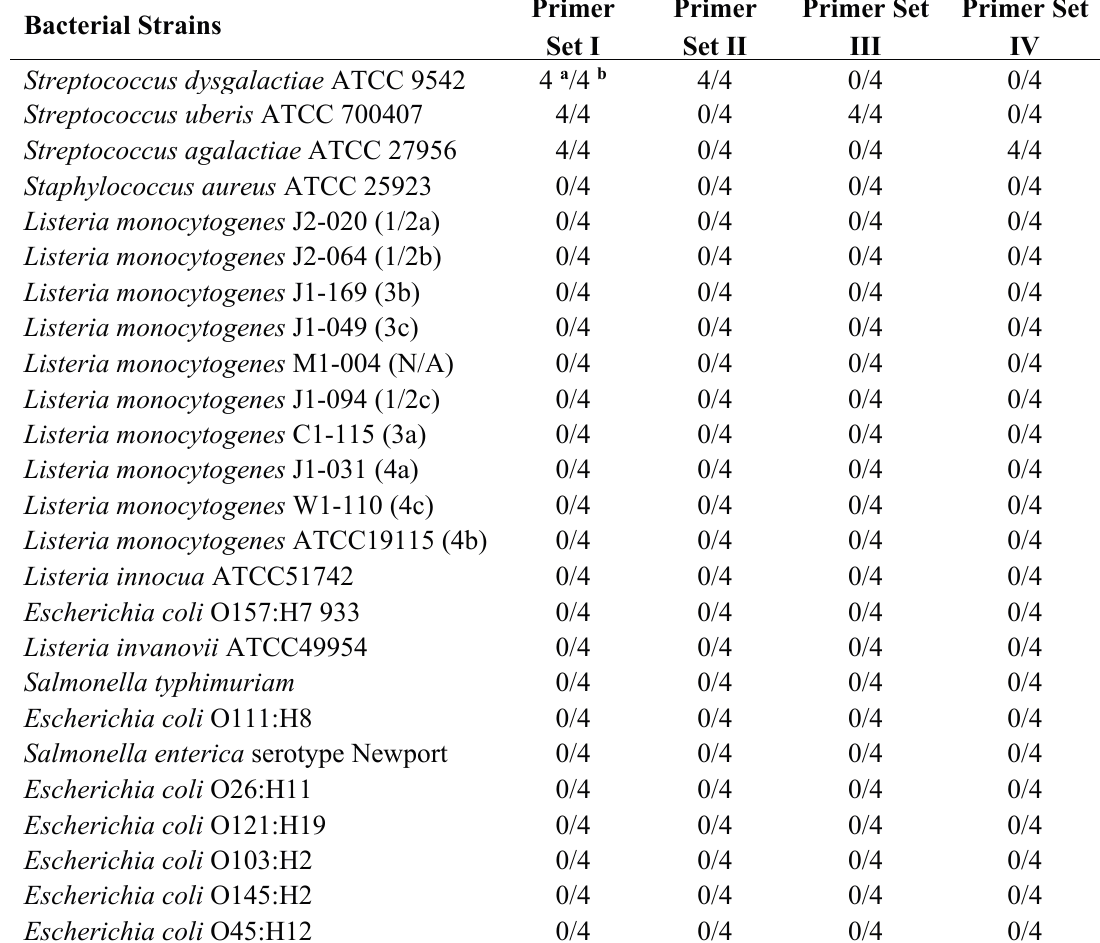
Table1. Bacterial strains used in this study and specificity of four LAMP primer sets. Bacterial